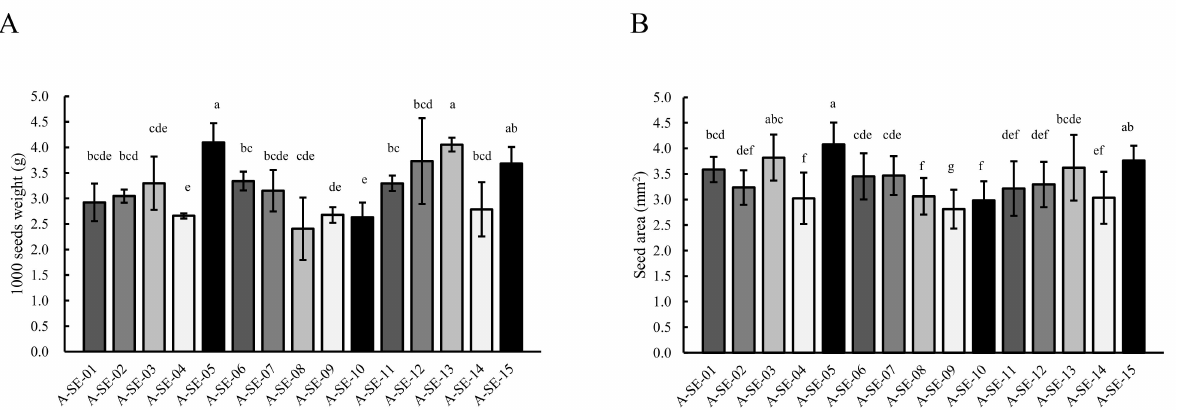
Figure 4. Seed weight and seed area. ( A ) Seed weight (g) and ( B ) area (mm 2 ) were determined among the different cultivars studied. Error bars represent the standard deviation. Bars that do not Scheme 0.